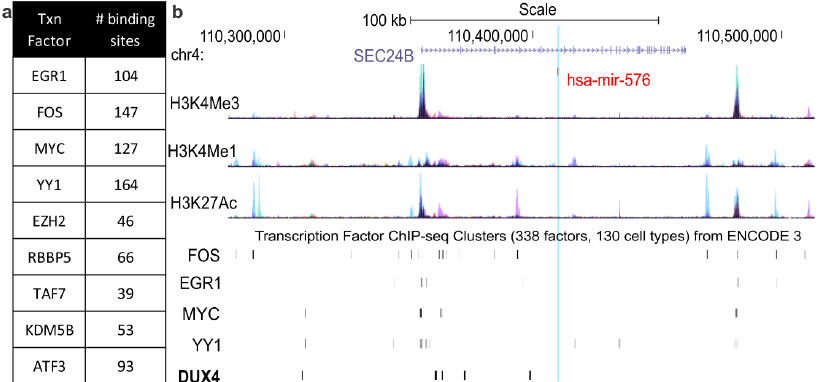
Figure 2. Candidate miRNA loci are consistent with regulation via transcription factors dysregulated in FSHD. ( a ) Table listing a subset of transcription factors which are each increased in human skeletal muscle cells in response to DUX4 overexpression [9], along with the number (#) of binding sites they show within potential regulatory distance (100 kb) of the 19 candidate miRNAs. ( b ) The miR-576 locus shows binding consistent with regulation by FOS, EGR1, MYC, YY1, and DUX4. Corresponding epigenetic modification maps display the location of histone modifications associated with active promoters (H3K4me3) and poised/active enhancers (H3K4me1 and H3K27Ac) in the vicinity of the miR-576 locus and its surrounding home gene, SEC24 homolog B ( SEC24B ). (DUX4 binding sites identified using ChIP-seq data uploaded from Geng et al. [9]; binding sites for additional transcription factors identified using UCSC Genome Browser and respective ChIP-seq datasets accessed via the ENCODE3 regulation track [46–50]).